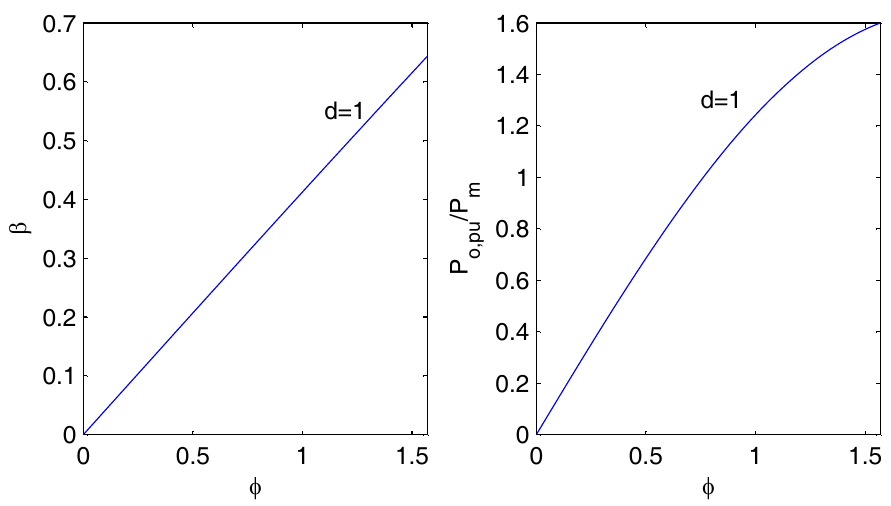
Figure 9. The variations of P o , pu / P m , β with regards to φ at d = 1.